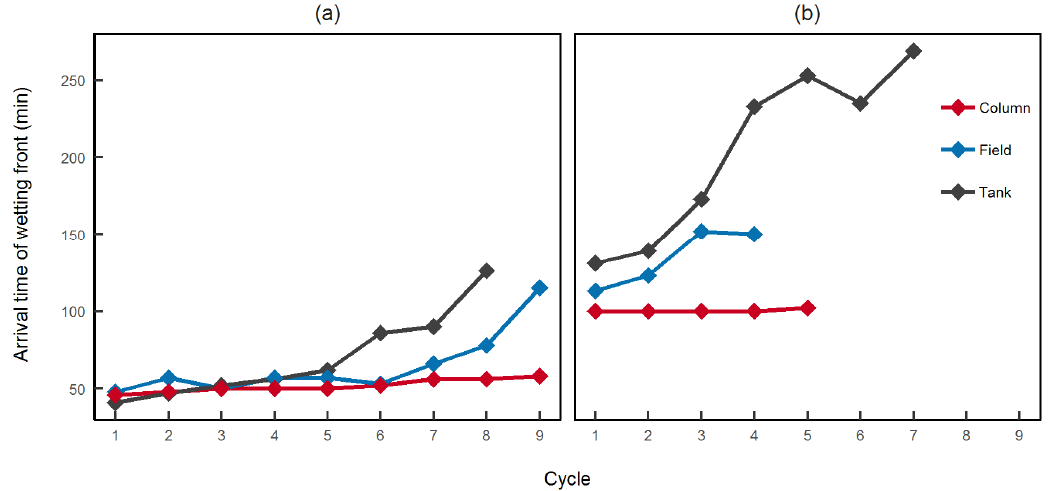
Figure 5. Increase of flow time between soil surface and point 2.2 for ( a ) scenario 1 (wet/dry ratio: 24 h/72 h) and ( b ) scenario 4 (wet/dry ratio: 72 h/24 h). Scenarios were aborted when overflow was detected, leading to different numbers of cycles for the setups.